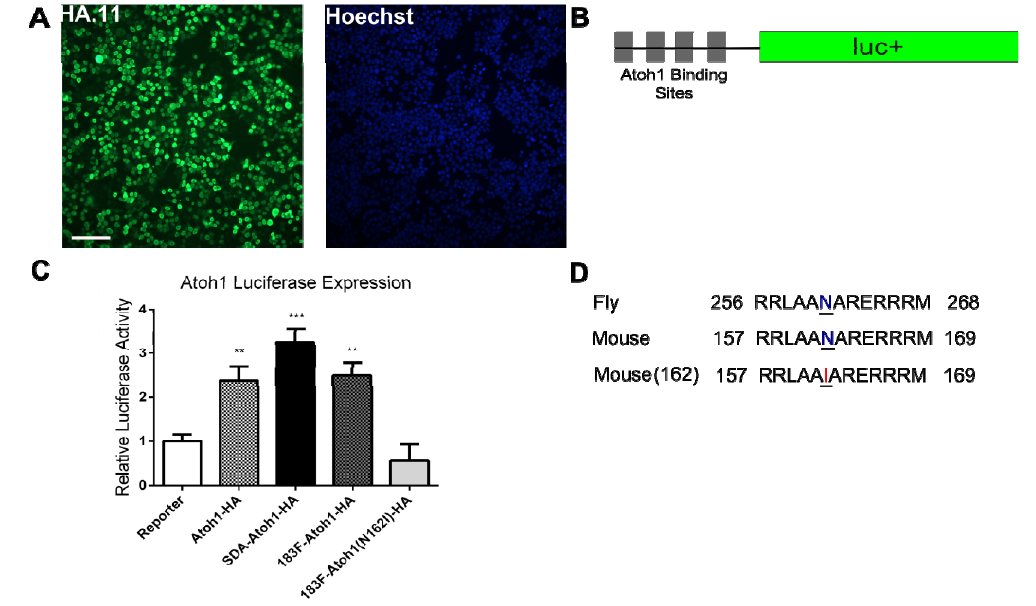
Figure 3. The Atoh1-HA fusion protein is functional and detectable by immunofluorescence. ( A ) Detection of Atoh1-HA fusion protein with HA.11 antibody in cells transfected with p183F-Atoh-HA. Scale bar = 100 microns; ( B ) Illustration of Atoh1 reporter construct; ( C ) Relative luciferase activity of cells transfected with Atoh1 reporter alone or with the indicated versions of the Atoh1-HA overexpression constructs. Luciferase activities are all referenced to cells transfected only with the reporter construct, which is set at 1.0. All constructs showed a significant increase in luminescence compared to the control except p183F-Atoh1(N162I)-HA. Each bar represents mean (±standard error) within each group. Each experiment was replicated at least three times; ( D ) Alignment of conserved Atoh1 segment between fly and mouse. Highlighted is the location of the amino acid mutated to make Atoh1 non-functional while maintaining the HA tag. * p < 0.05, ** p < 0.005, *** p <